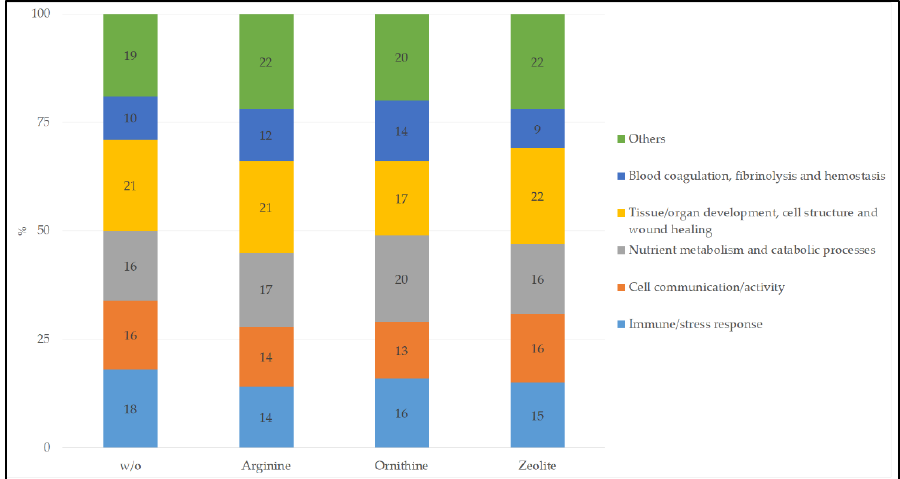
Figure 1. Summary of the biological processes associated with urinary proteins of cats ( n = 4) fed a high-protein diet without (w/o) or with arginine, ornithine or zeolite. More details on the single biological processes can be found in Tables 1–6. Table 1. Urinary proteins associated with biological processes 1 related to the immune/stress response, detected in the urine of cats ( n = 4) fed a high-protein diet without (w/o) or with the supplementation of arginine (Arg), ornithine (Orn) or zeolite (Ze). Mean number of proteins ± standard